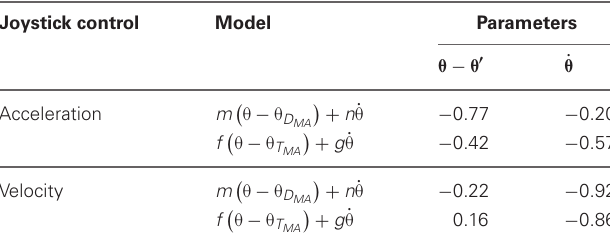
Table 6 | Standardized coefficients for predictor variables of models for group performance as a function of ground texture.